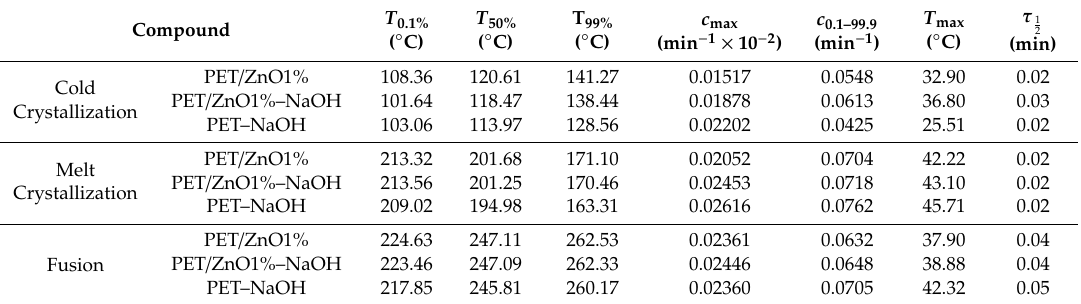
Table 2. Thermodynamic and kinetic parameters of crystallization and fusion obtained from DSC scans. Compound